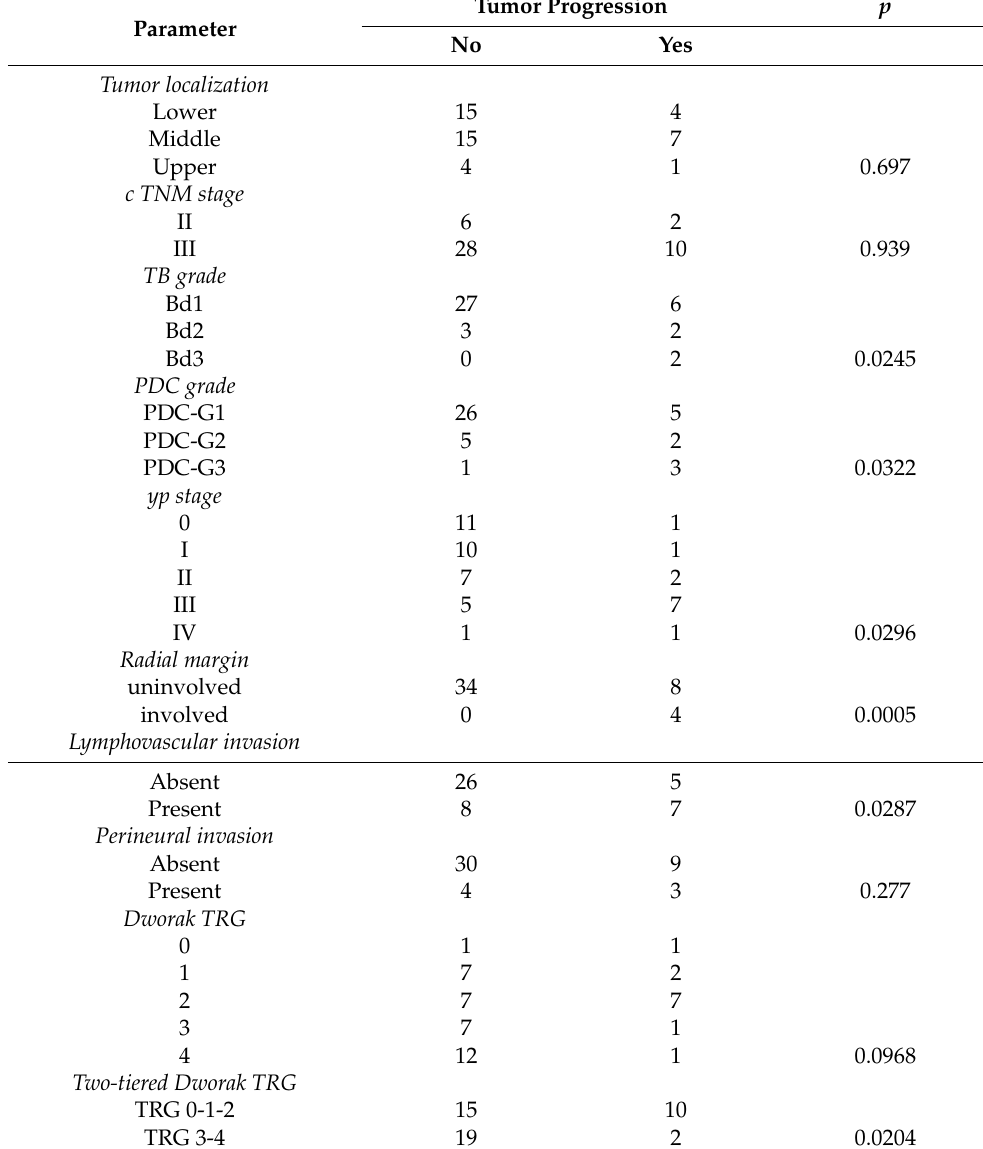
Table 2. Statistical correlations between clinical–pathological parameters and tumor progression in 46 rectal adenocarcinomas treated with neoadjuvant chemo-radiotherapy and